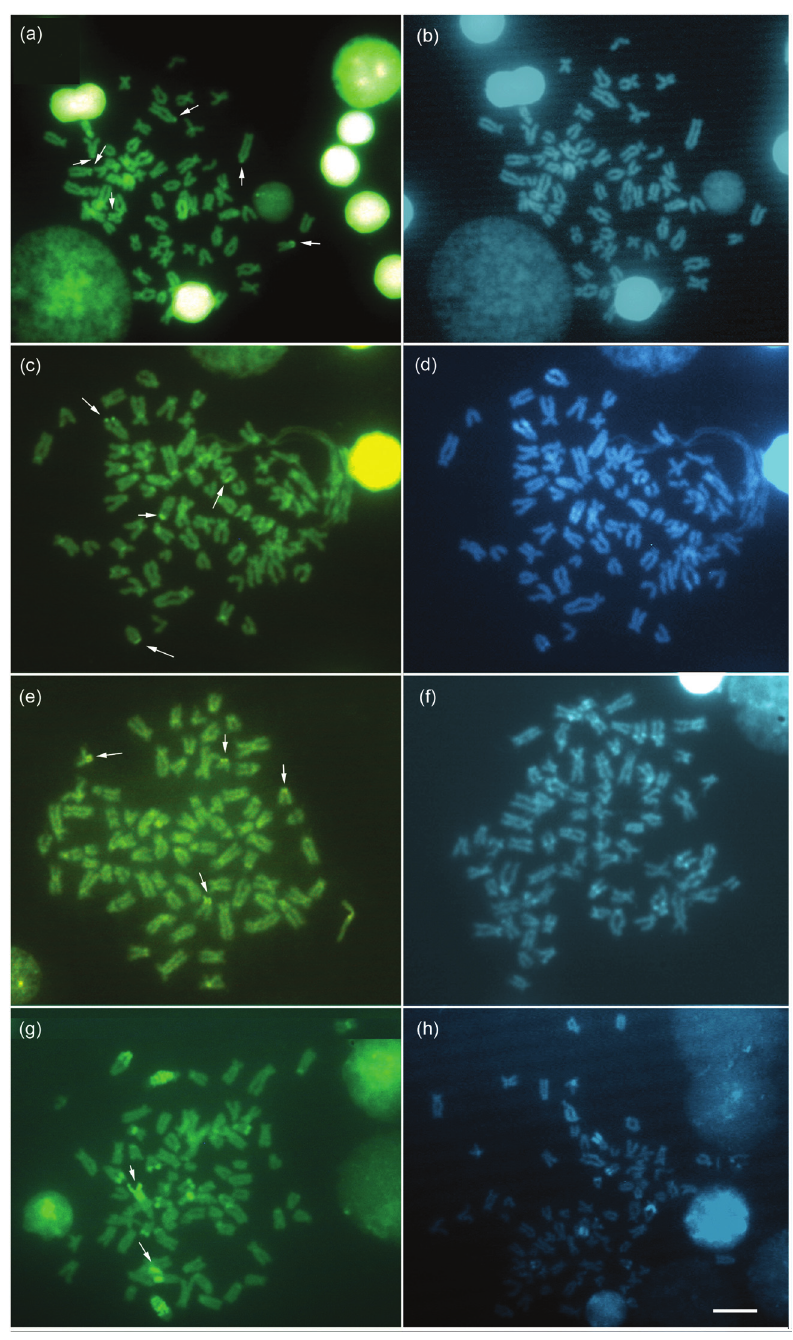
Figure 2. Metaphases stained with CMA (left) and DAPI (right), of H. ancistroides a, b H. strigaticeps 3 c, d H. regani e, f H. paulinus g, h . The arrows indicate the NOR-bearing chromosomes. Bar = 10 µ